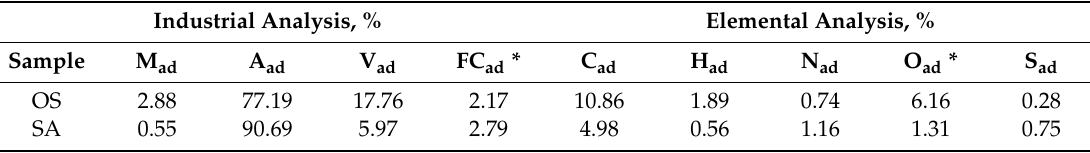
Table 1. Industrial analysis and elemental analysis of oil shale (OS) and shale ash (SA). Industrial Analysis, % Elemental Analysis,